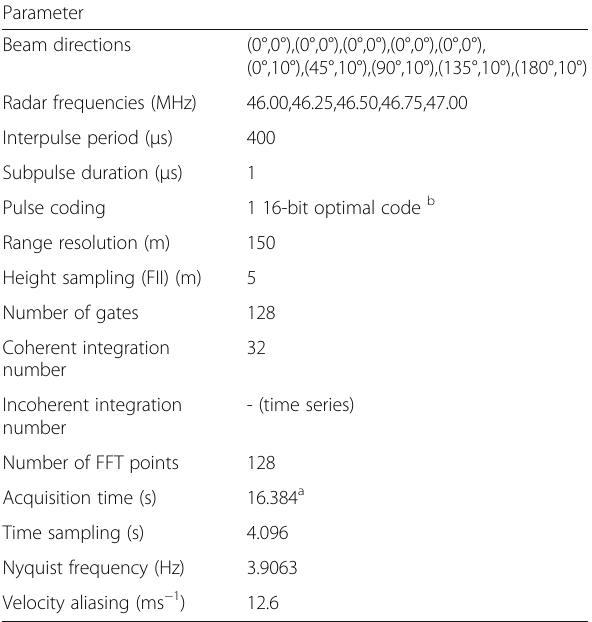
Table 2 MU radar parameters used during ShUREX 2015 campaign Parameter Beam